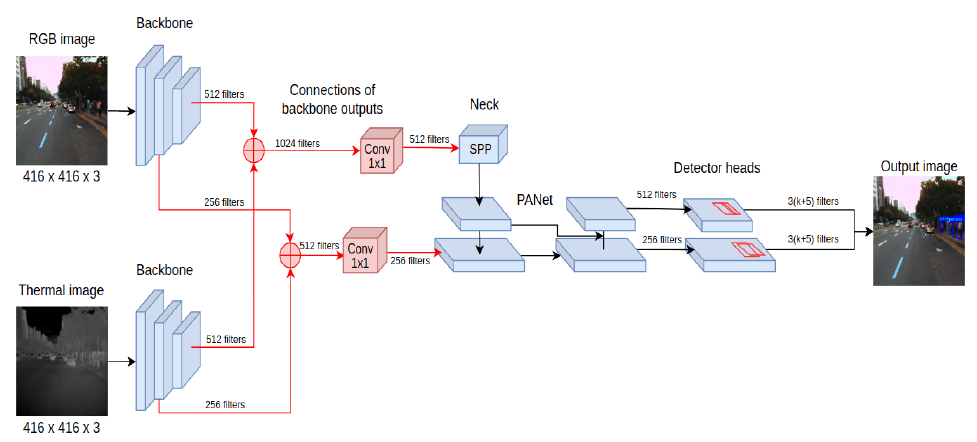
Figure 9. The processing pipeline of the YOLO4-Middle-Tiny detector. It extracts independent features from RGB and thermal inputs that are combined on different processing levels before the layers responsible for object